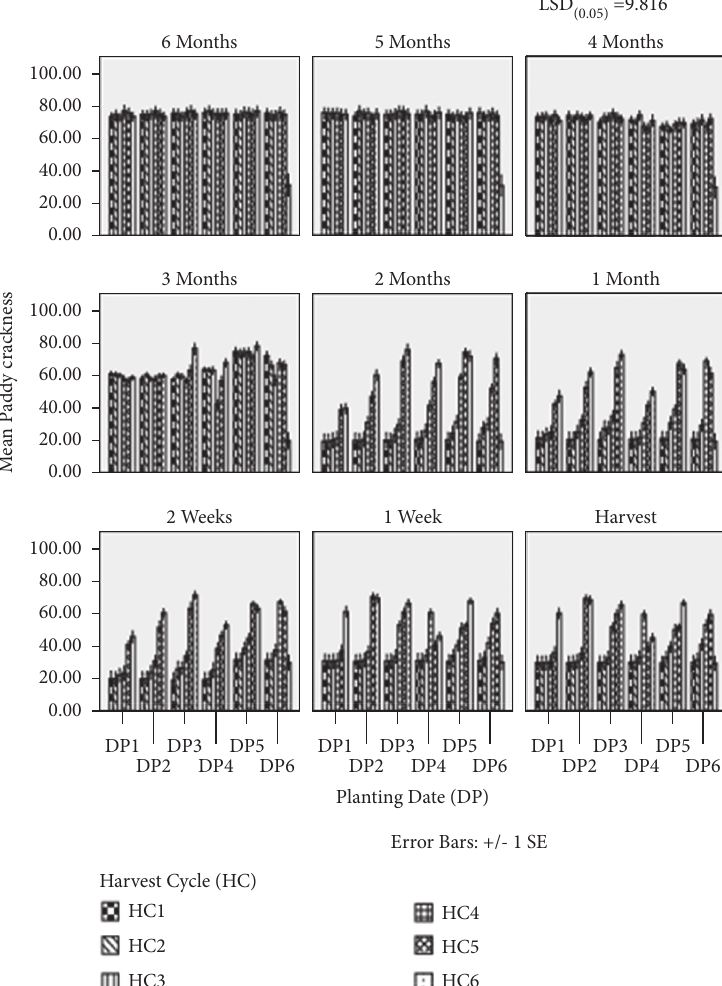
Figure 11: Effect of planting date, harvest cycle, and storage duration on mean paddy cracking in the Northern Savanna Agroecological Zone of Ghana. Bars represent the SEM. DP1 � first planting, DP2 � second planting, DP3 � third planting, DP4 � fourth planting, DP5 � fifth planting, DP6 � sixth planting, V1 � Agra, V2 � Gbewaa, V3 � Exbaika, V4 � Perfume Irrigated, HC1 � first harvest, HC2 � second harvest, HC3 � third harvest, HC4 � fourth harvest, HC5 � fifth harvest, and HC6 � sixth Table 1: Pearson’s correlation matrix between paddy crackness, grain moisture (GM), and duration of storage (SD). Values are coefficient.